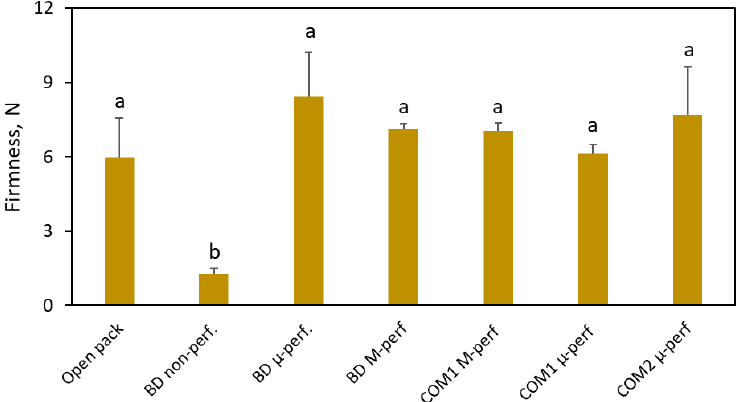
Figure 8. The effect of packaging on the firmness of bananas after 3 days of simulated distribution at 15 °C and 5 days of shelf life/home storage at 24 °C. Package designations are the same as in Figure 2. Error bars represent standard errors of three replications. Different letters above the bars indicate significant differences at p ≤ 0.05, according to Tukey ’ s HSD test.